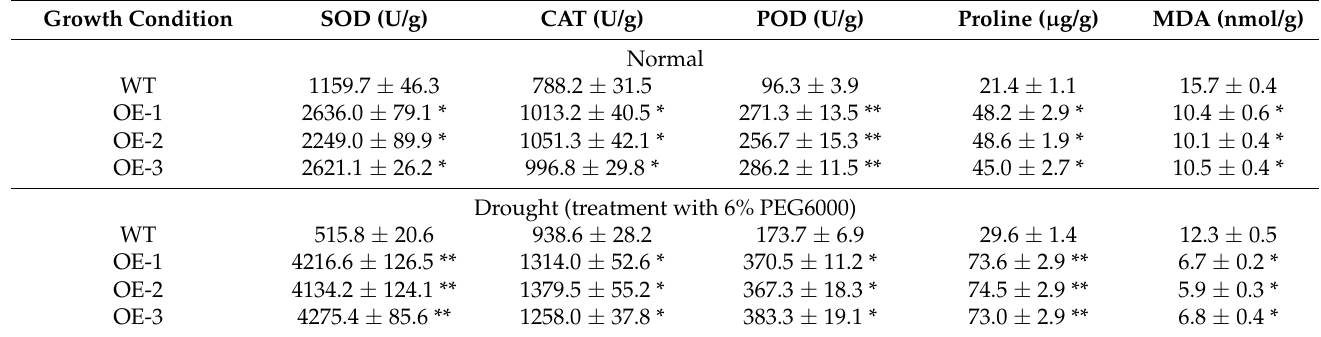
Table 2. Variations of physiological indices, i.e., the enzymatic activities of superoxide dismutase (SOD), catalase (CAT), and peroxidase (POD), and contents of proline and malondialdehyde (MDA), in transgenic Arabidopsis thaliana with overexpression of GmNAC3 gene under normal growth condition and drought stress. Data are presented as mean ± standard deviation ( n = 3). WT, wild type. Symbols “*” and “**” indicate significant differences at p values of 0.05 and 0.01, respec- tively.